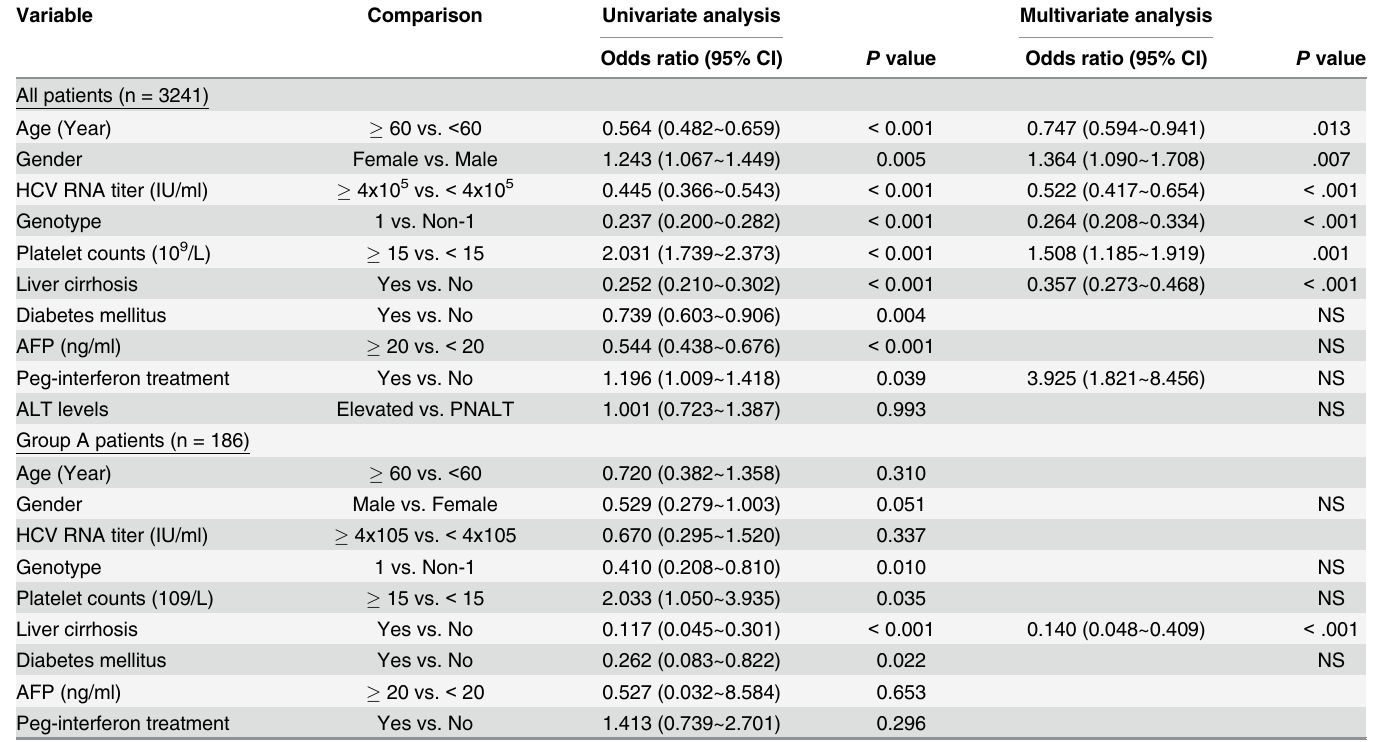
Table 3. Univariate and Multivariate analysis of factors associated with SVR. Variable Comparison Univariate analysis Multivariate